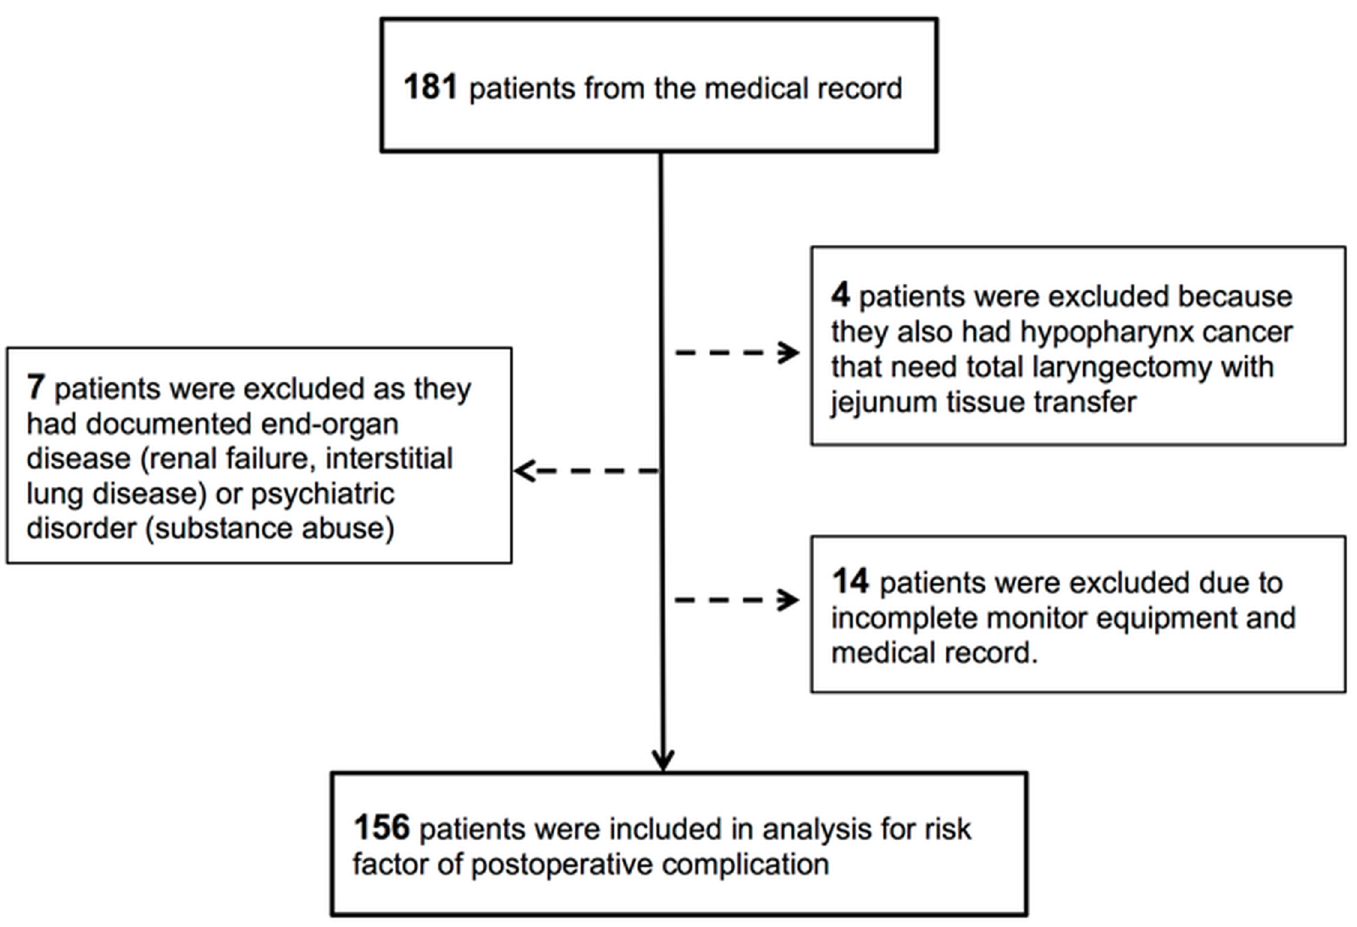
Fig 1. Flow chart of the retrospective study. One hundred and eighty patients were enrolled from medical records using key words “ free flap reconstruction ” . Four patients were excluded because they also had hypopharynx cancer that needed not only free flap reconstruction but also jejunum tissue transfer. Seven patients were excluded because they either had end-organ disease or a psychiatric disorder that may have complicated their recovery course. Finally, fourteen patients were excluded due to incomplete medical records. A total 156 of patients were included in the final analysis.